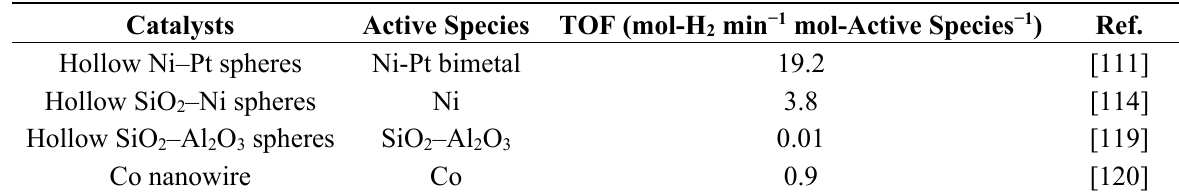
Table 2. TOF of various